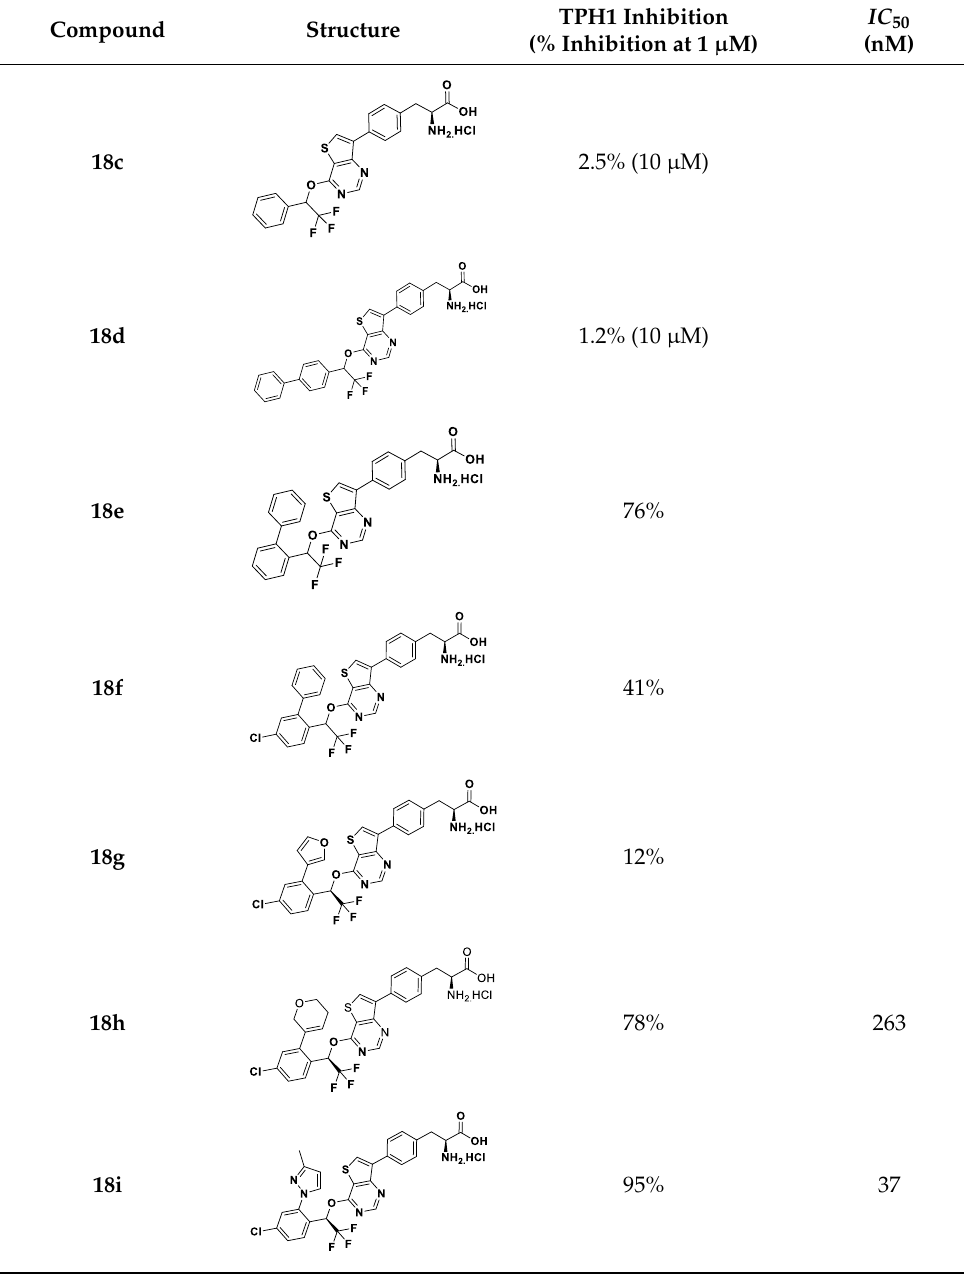
Table 3. In vitro test of amino thienopyrimidine derivative and prodrugs of compound 18i .